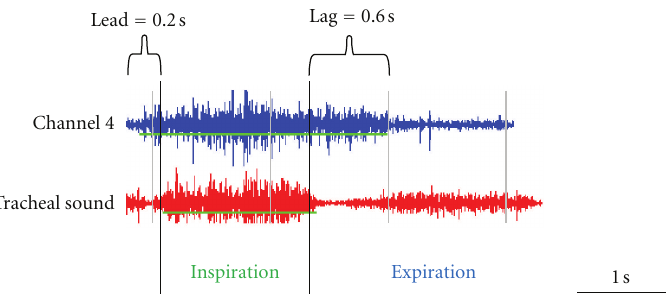
Figure 3: Calculations of the lead and lag. The thin horizontal green line under each channel waveform indicates the duration of inspiration at that channel. The thick vertical black lines indicate the beginning and the end of inspiration at the trachea.